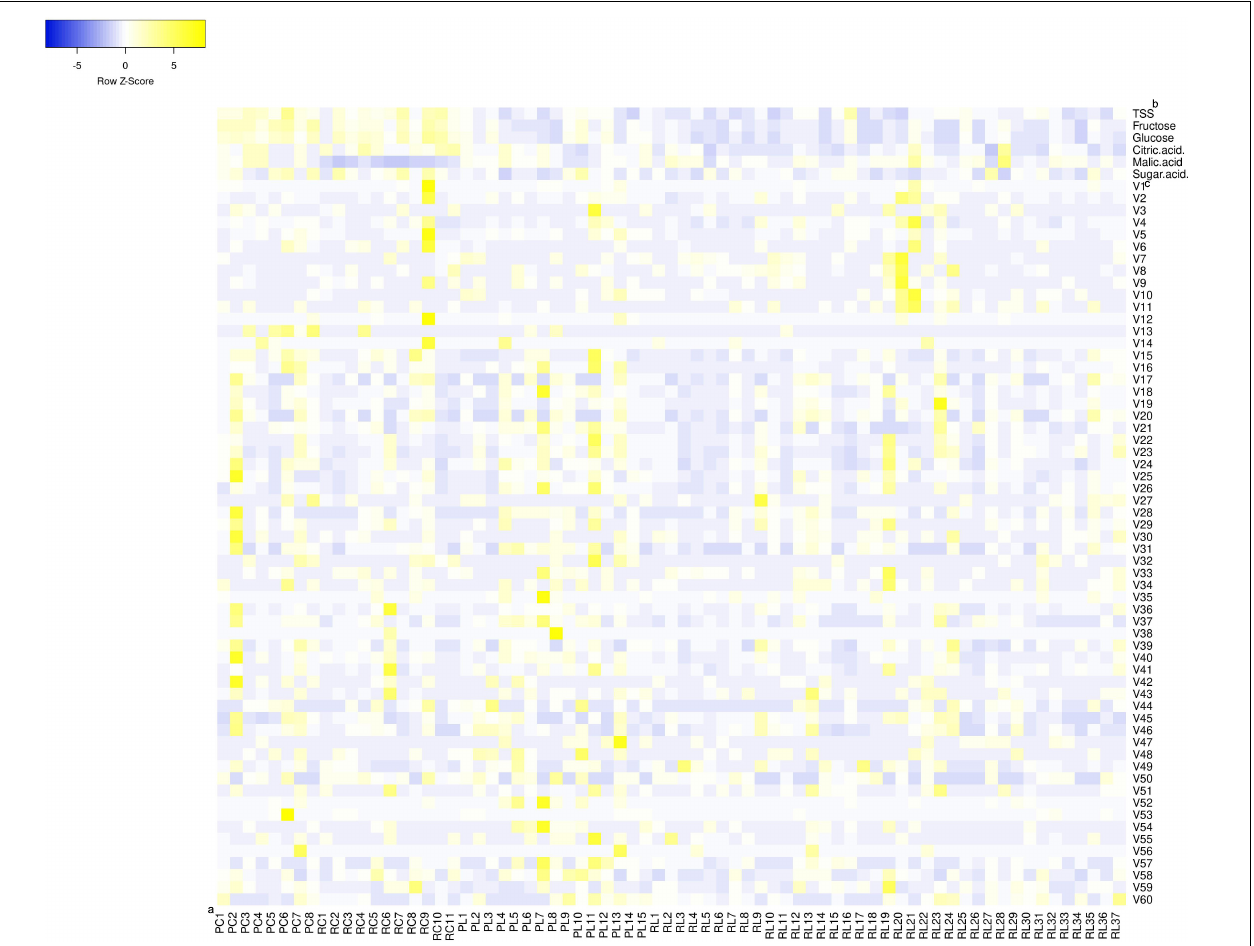
FIGURE 1 | Heat map of concentrations of flavor compounds in mature tomato fruits. a PC, PL, RC, and RL indicate pink cherry tomato, pink large-fruited tomato, red cherry tomato, and red large-fruited tomato, respectively. b TSS represents the total soluble solids. c V1–V60 represents the volatiles from top to bottom in Table 2 ,